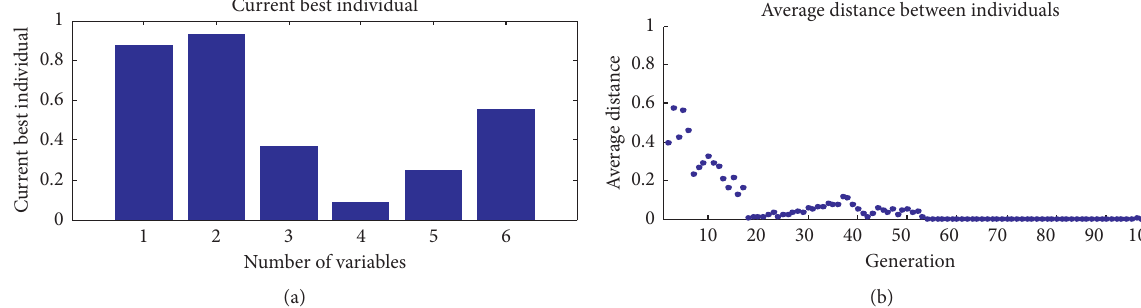
Figure 4: Variation of evolutionary individual optimal and evolutionary